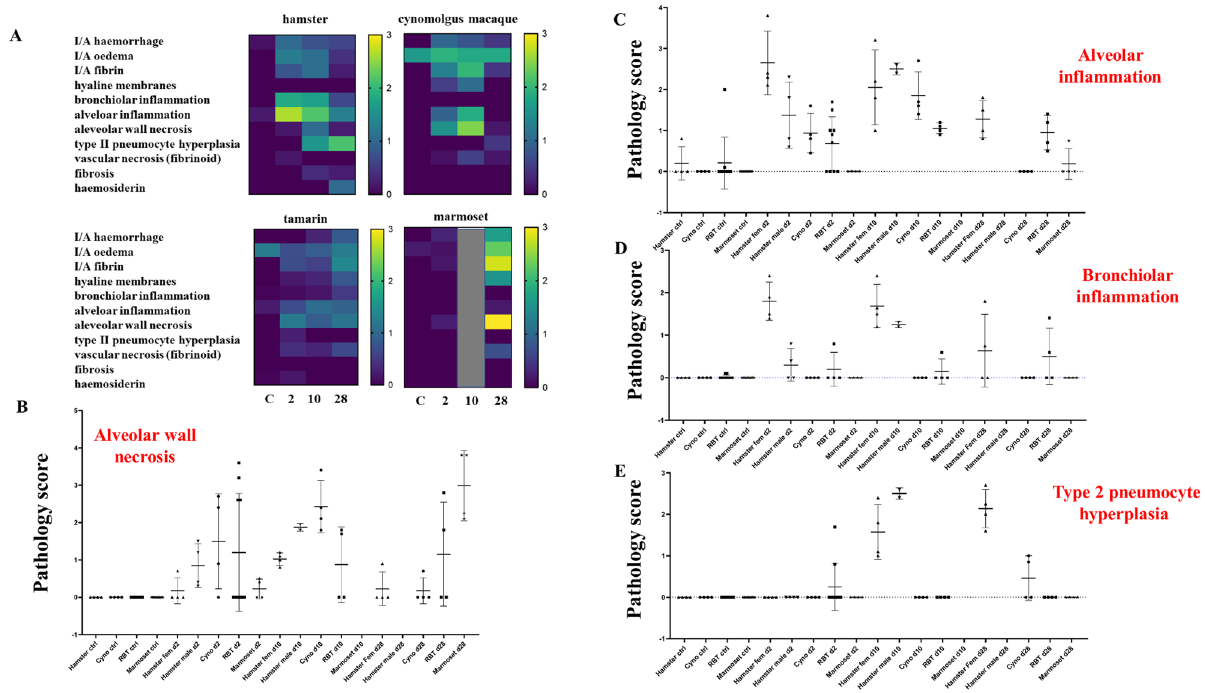
scores of overall pathology for each of alveolar wall necrosis, alveolar inflammation, bronchiolar inflammation and type 2 pneumocyte hyperplasia across the time-course for each of the four species. Cyno cynomolgus macaque, RBT red-bellied tamarin. Heat map graphics generated using GraphPad Prism version 9.3